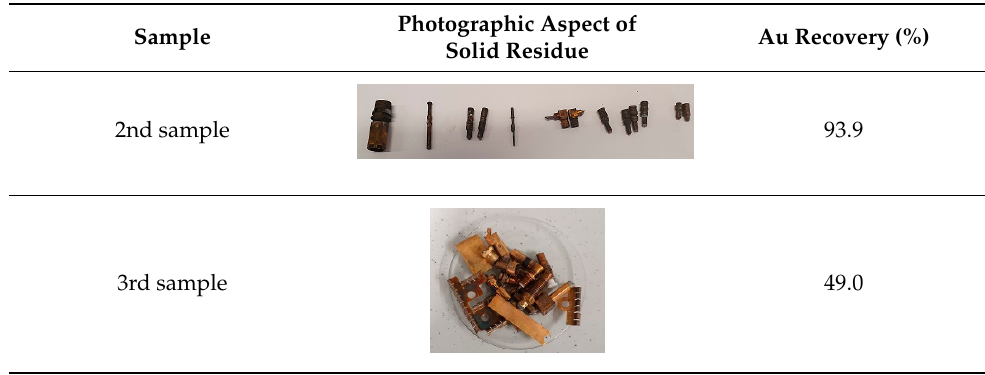
Table 4. Gold content within leaching solution and recovery.